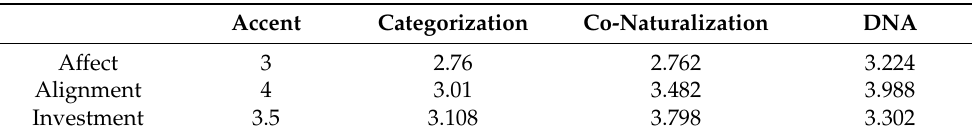
Table 5. Mean stance dimension weights by